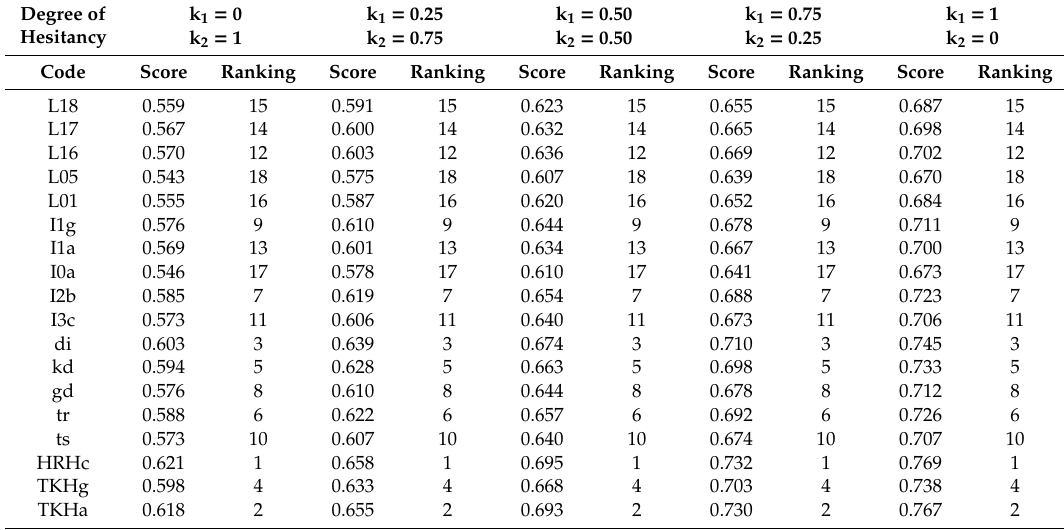
Table 11. Ranking of Errors Based on the Importance of Values (Preventability ×